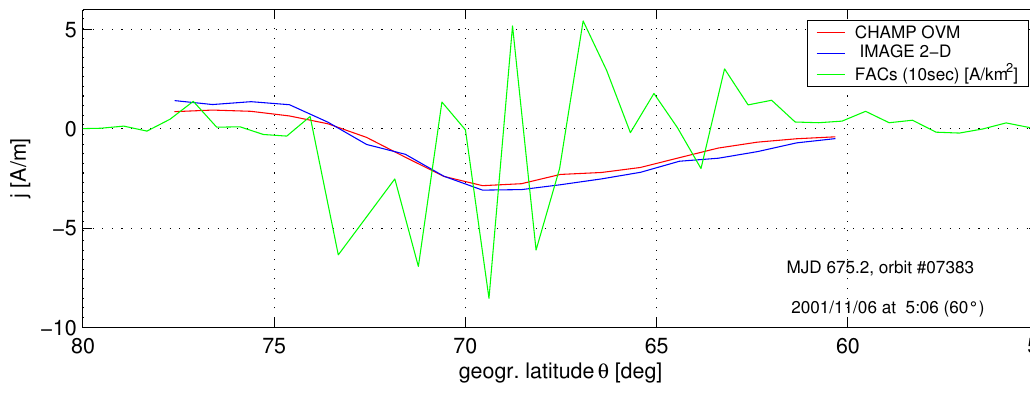
Fig. 6. Hall currents and field-aligned currents (10-s running mean) during the storm event on 5/6 Nov. 2001.